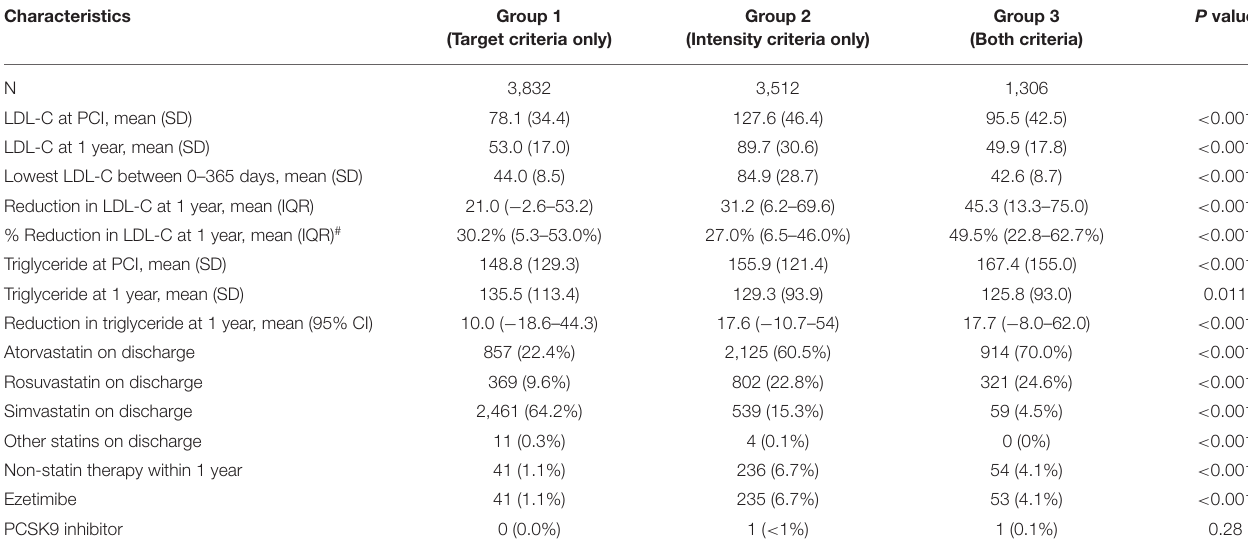
TABLE 2 | Lipid profile (values in mg/dl) and lipid lowering treatment.